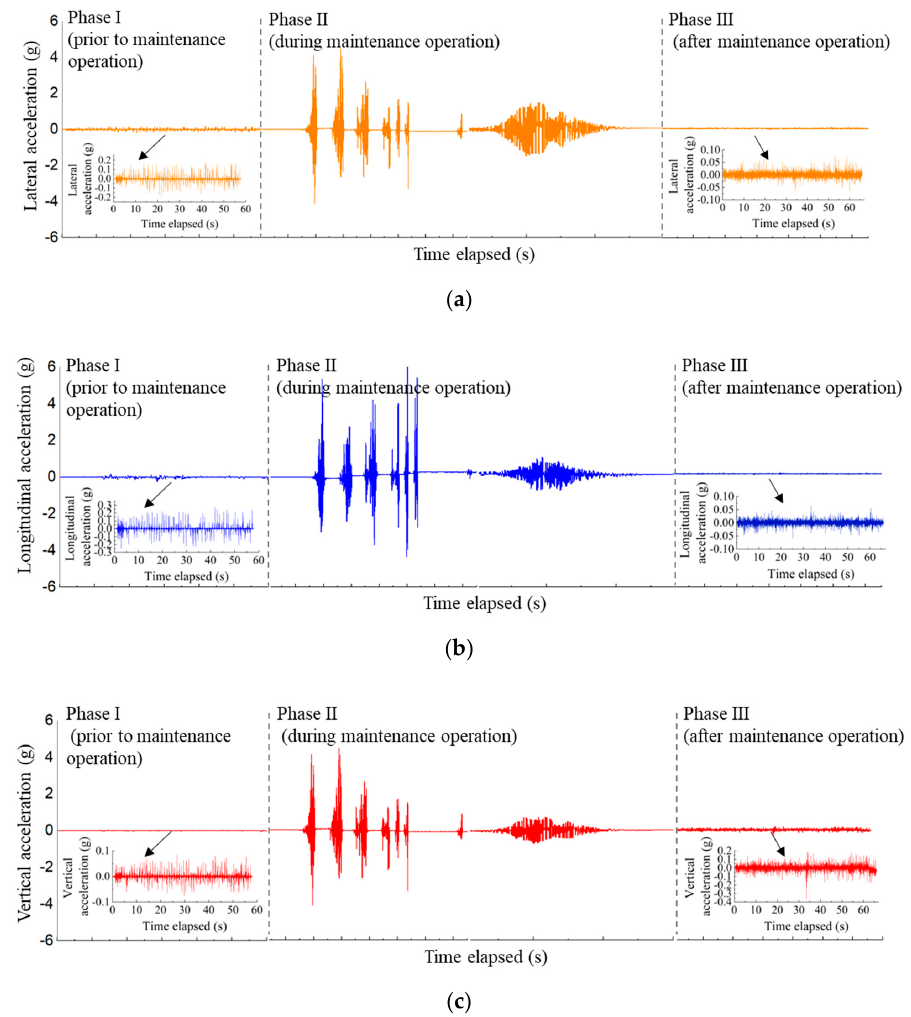
Figure 11. The time-history curves of processed ( a ) lateral, ( b ) longitudinal, and ( c ) vertical acceler- ation responses recorded by #R1 prior to, during, and after maintenance